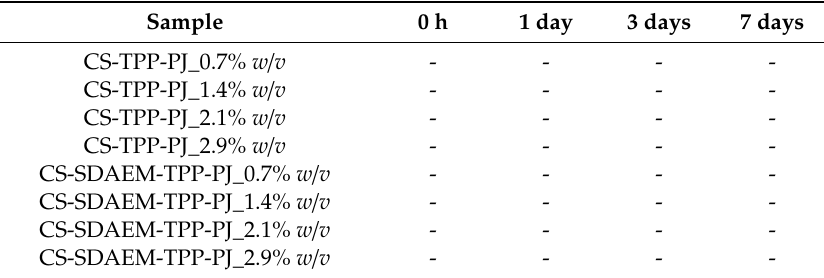
Table 5. Physical characterization of the emulsions after